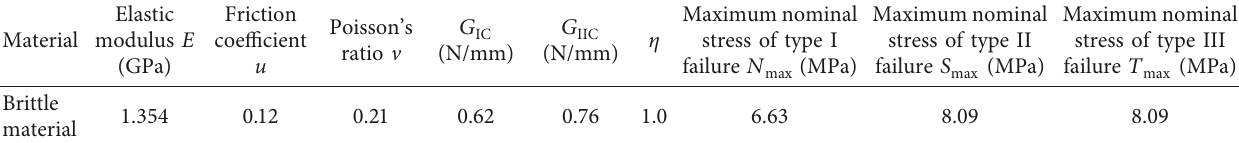
Figure 5: Calculation model diagram of single-crack sample ( r � 0): (a) closed crack: crack angle β � 15 ° , crack thickness d � 0.5mm; (b) nonclosed crack: crack angle β � 45 ° , crack thickness d � 2mm. Table 2: Numerical parameters for